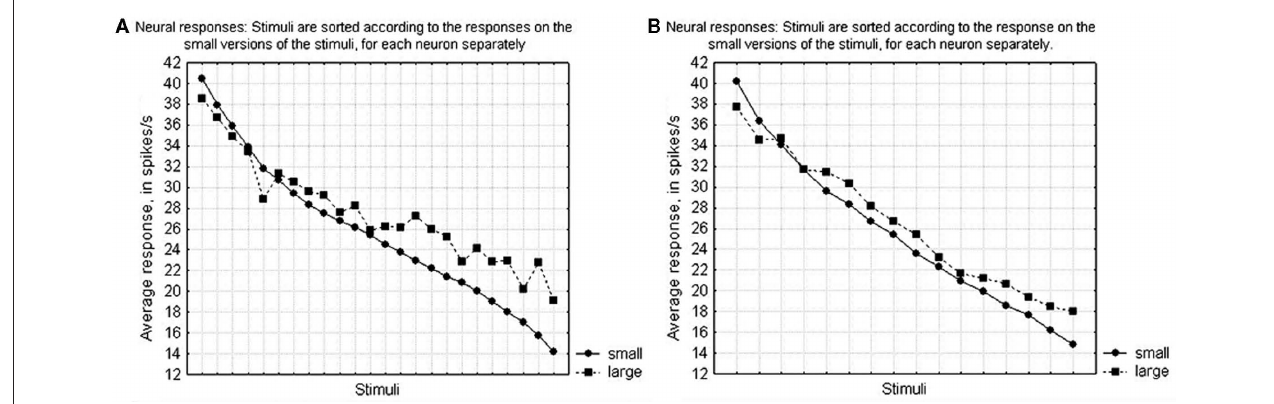
Figure 10 | Average preservation of the selectivity of the iT neurons over changes in size. Stimuli are sorted according to the response strengths for the small versions of the stimuli, for each neuron separately, and the average response is shown for either the small versions (circles) or the large versions (squares). (A) For the stimuli in subset 1 (the first three rows of Figure 2 ). (B) For the stimuli in subset 2 (the last two rows of Figure